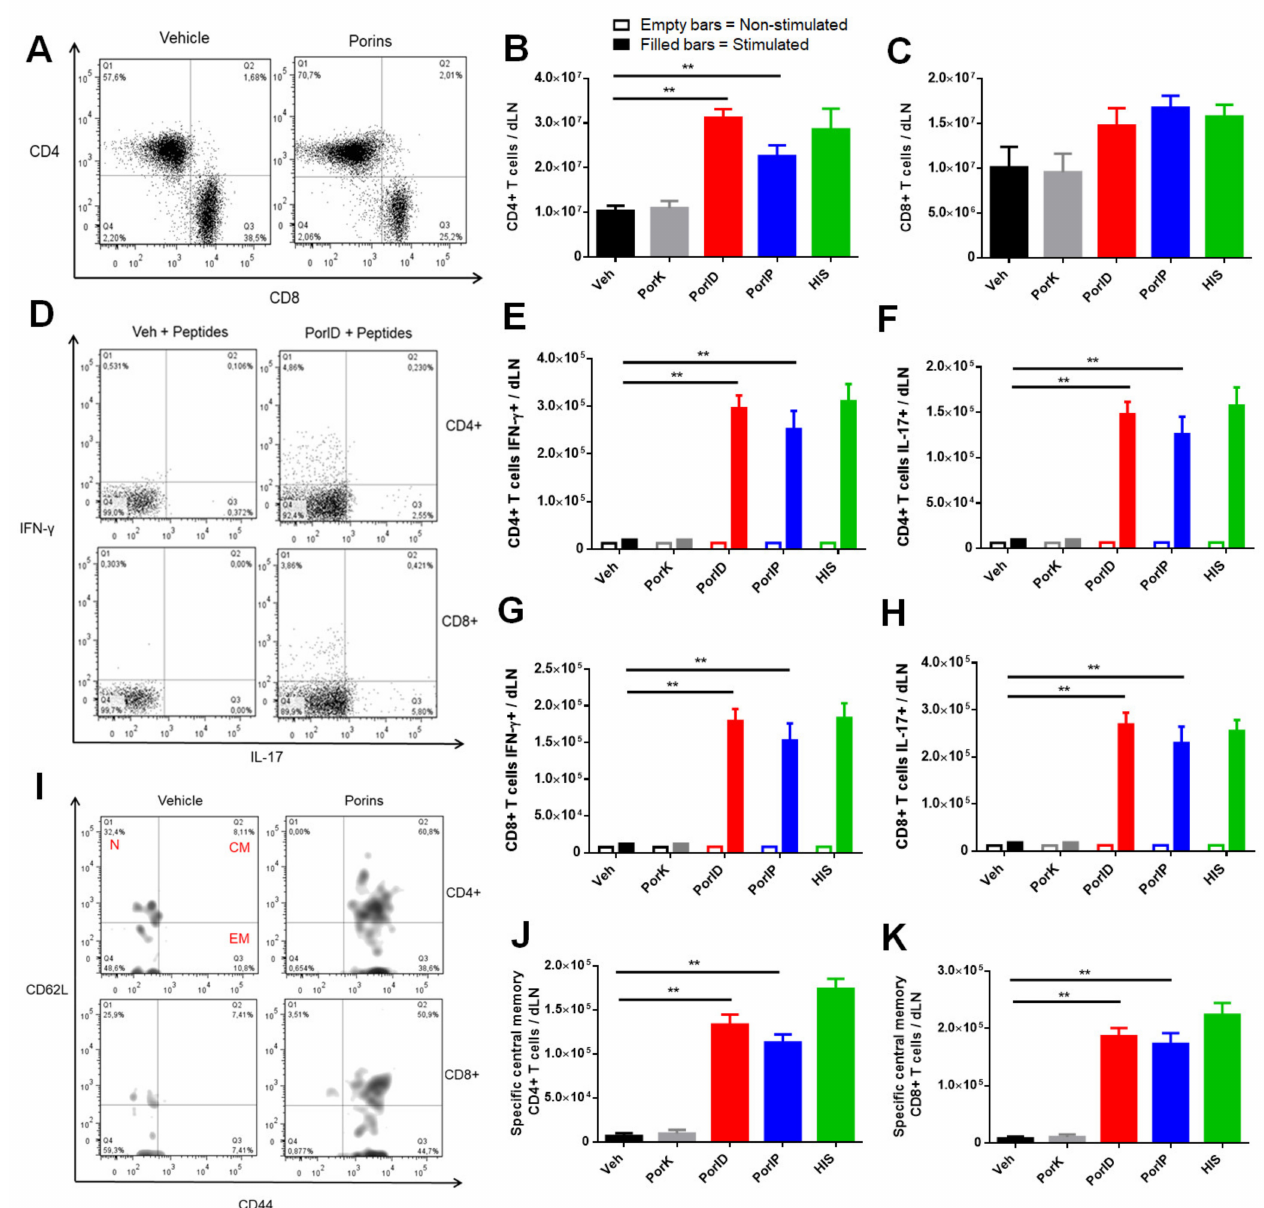
Figure 3. Vaccination with S . Typhi porins induces functional central memory CD4+ and CD8+ T cell responses. C57BL/6J mice were injected intradermally in the ear with vehicle (Veh), proteinase K-digested porins (PorK), porins (PorID), or intraperitoneally with porins (PorIP) or heat-inactivated S . Typhi (HIS) at day 0. All groups were boosted at day 14 with porins injected intradermally in the ear. T cells from the skin dLN were analyzed at day 28. Representative plot of the count of cell number ( A ) for both CD4+ ( B ) and CD8+ ( C ) populations in the skin dLN. Representative plot used ( D ) to analyze expression of IFN- γ and IL-17 in CD4+ and CD8+ dLN T cells following stimulation with S . Typhi porin peptides. Total number of IFN- γ - ( E ) and IL-17- ( F ) producing CD4+ T cells. Total number of IFN- γ - ( G ) and IL-17- ( H ) producing CD8+ T cells. Central memory phenotype (CD44+, CD62L+) was evaluated in skin dLN porin-specific T cells. Representative plot ( I ) used to analyze central memory CD4+ ( J ) and CD8+ ( K ) populations (CM, central memory, EM, effector memory, N, naive) ( n = 7; 2 independent experiments; significant difference for a Kruskal–Wallis test ** p < 0.05 with Dunn’s multiple